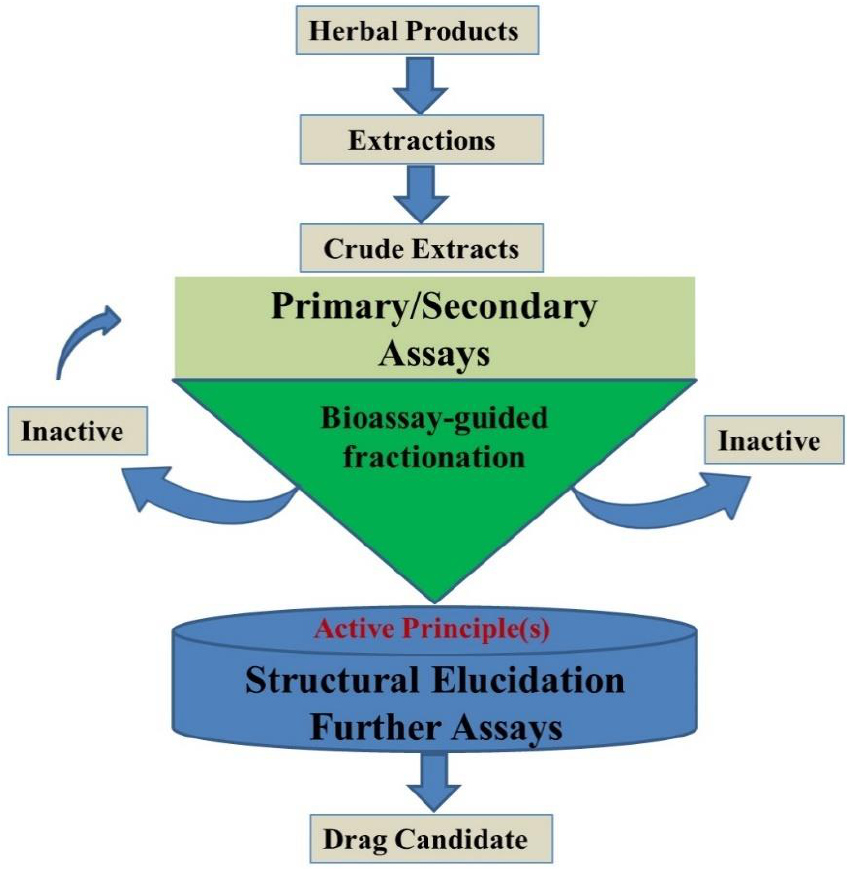
Figure 3. Steps required for the characterization of a bioactive compound from natural sources.